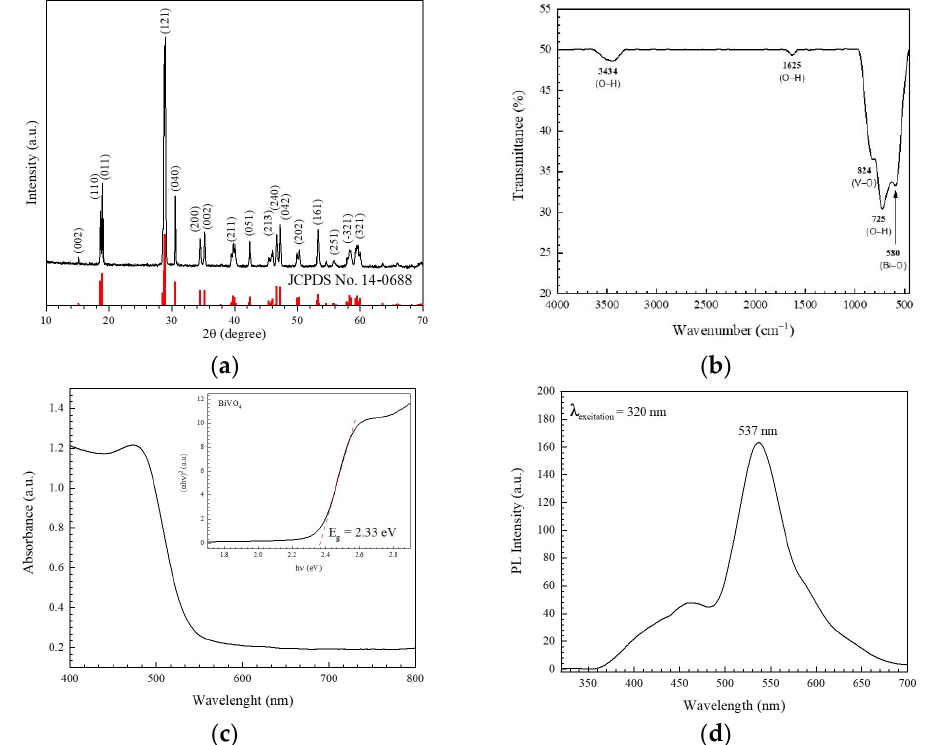
Figure 1. XRD pattern ( a ), FT-IR ( b ), UV-Vis ( c ), and PL spectrum ( d ) of the prepared BiVO 4 catalyst.